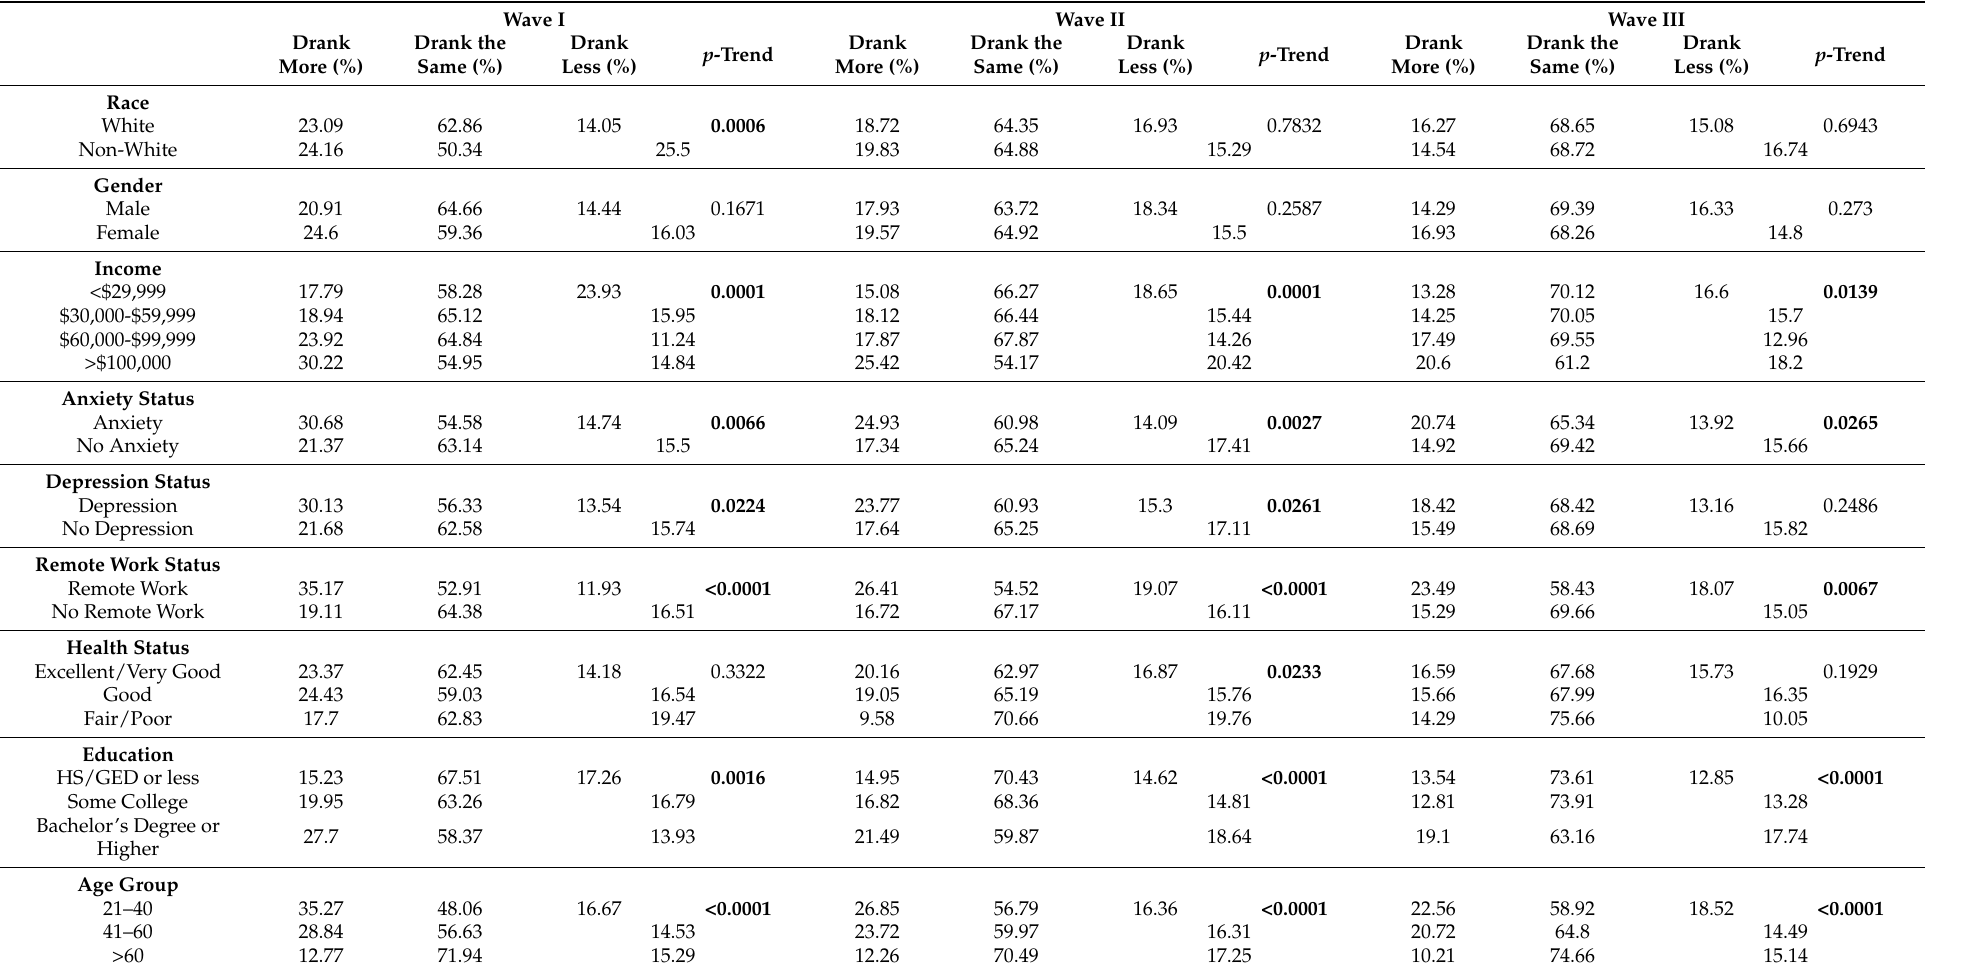
Table 2. Changes in Alcohol Consumption by